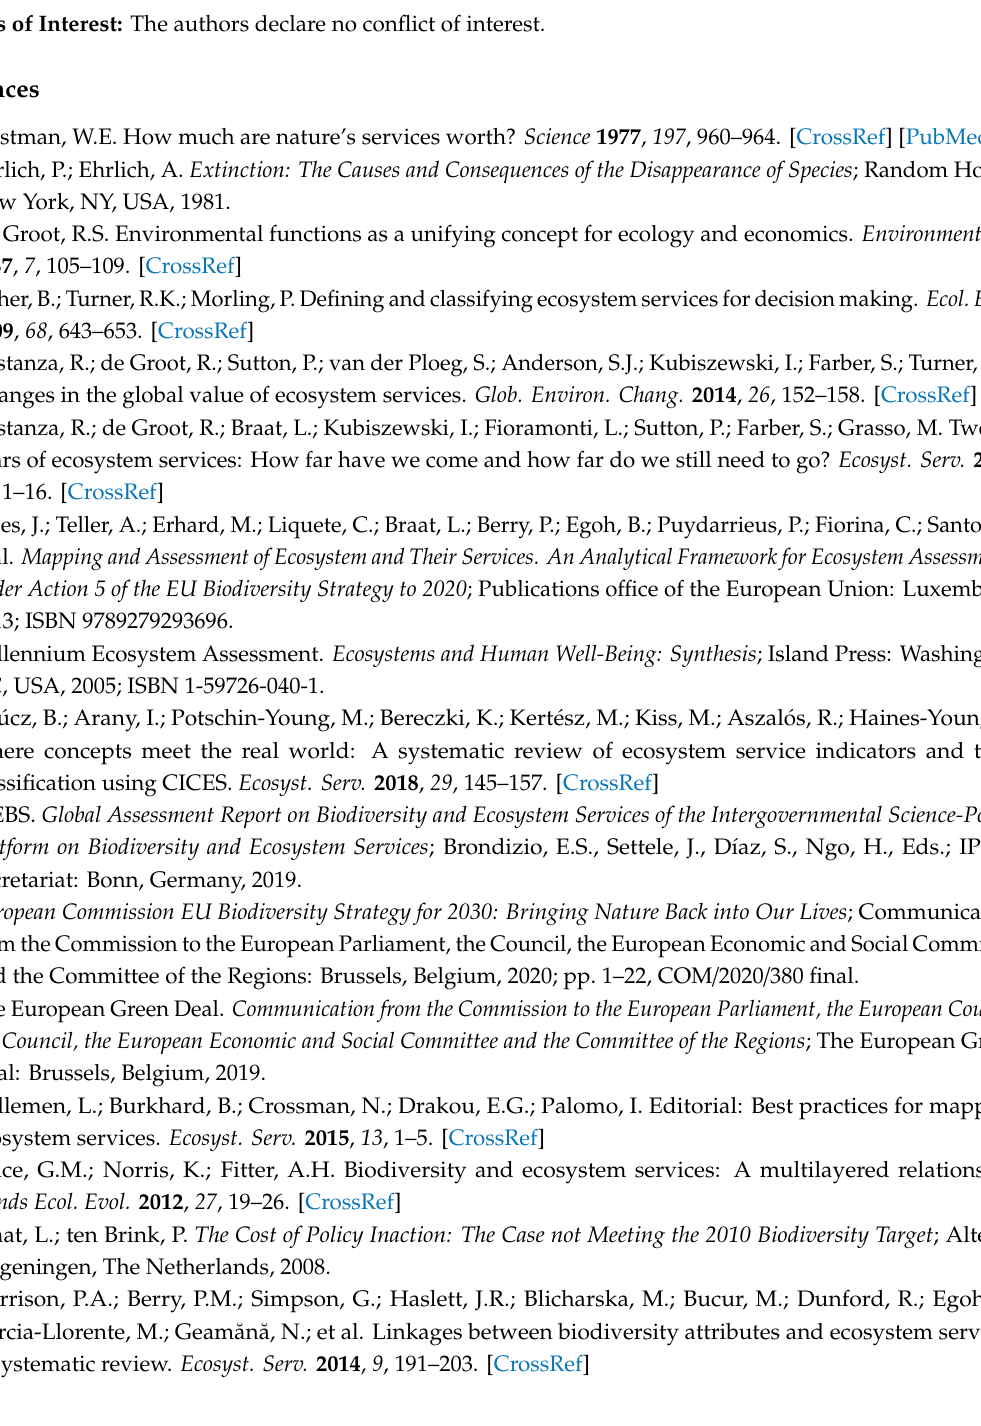
Table S1: Detailed data information for each grid cell used for the